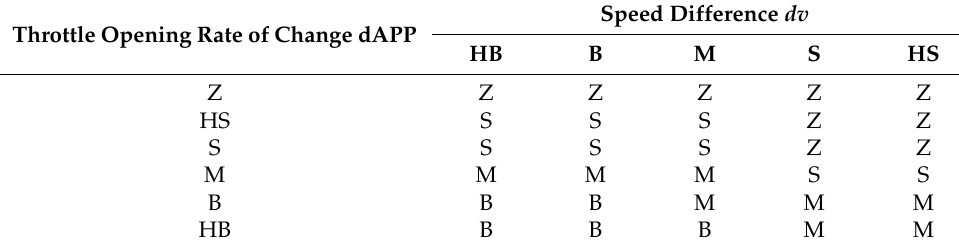
Table 2. Fuzzy rules of compensation torque.